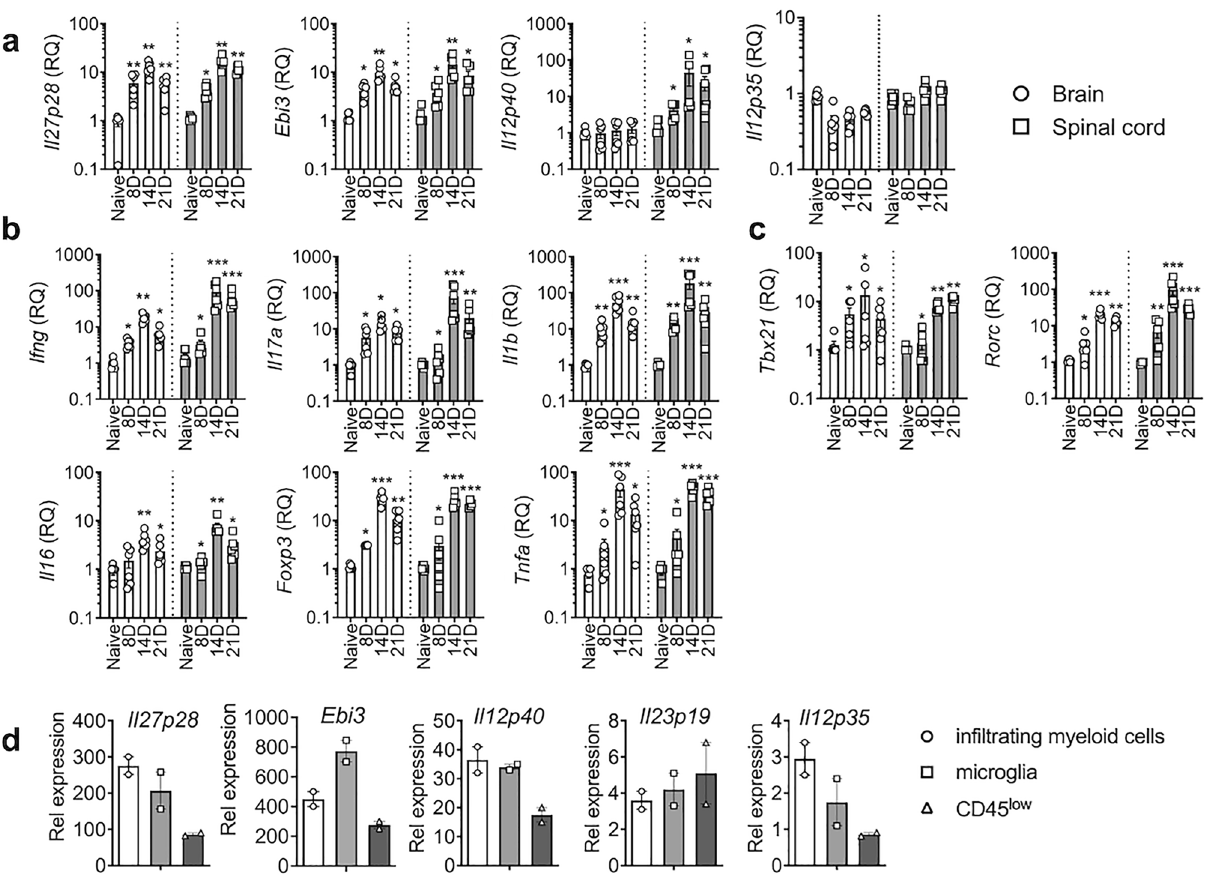
Figure 1. Cytokine gene expression in the CNS during EAE. ( a – c ) EAE was induced in C57BL/6 mice as described in the “Methods”. RNA was isolated from the brain and spinal cords at disease onset (day 8 post immunization), acute phase (day 14 post immunization) and remission phase (day 21 post immunization). n = 4–6 per group. mRNA expression of IL-12 family genes, cytokines and transcription factors were measured by qRT-PCR. Data were normalized by Gapdh gene expression and compared to that of naive mice. ( d ) CD45 high CD11b high (infiltrating myeloid cells), CD45 int CD11b high (microglia) and CD45 low (including astrocyte and oligodendrocyte) cells were sorted from the CNS at the peak of disease (day 17 post immunization) and expression of the indicated genes was measured by qPCR. Gene expression was normalized by Gapdh and compared to that of naïve mice. The results shown represent two independent experiments. *p < 0.05; **p < 0.01; ***p < 0.001; as determined by Mann–Whitney nonparametric